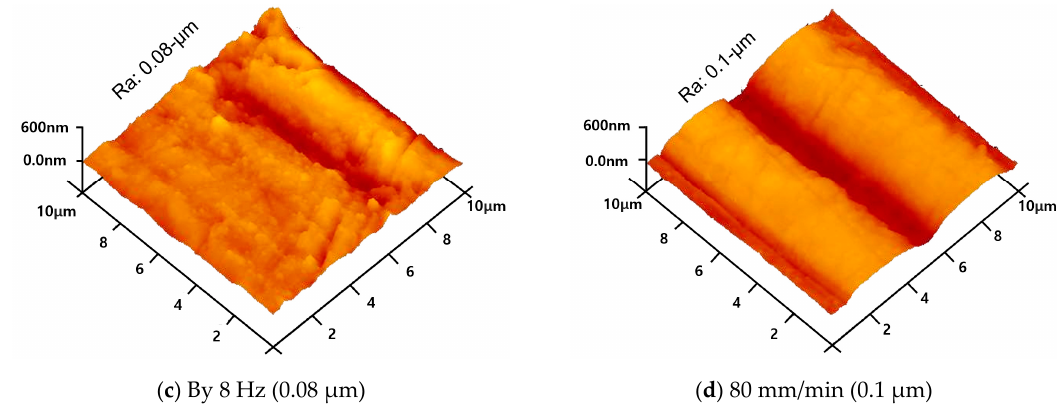
Figure 13. Atomic force microscopy (AFM) 3D image of the workpiece before and after finishing process according to multi-transportation system employed.